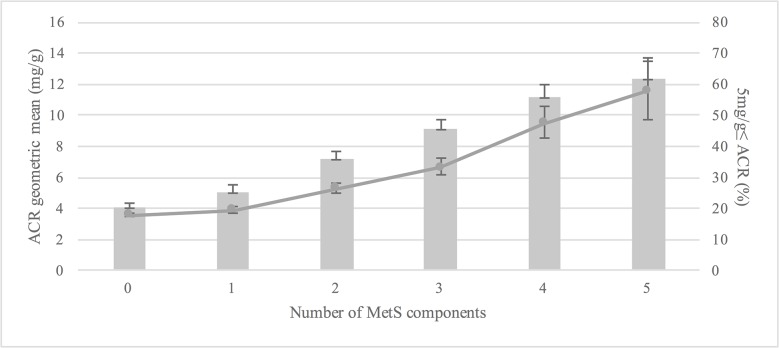
The geometric mean ACR values and the percentage of subjects with ACR values over 5 mg/g with an increase in the number of MetS components.All p for trends are <0.001. The geometric mean values of ACR were presented as a line, and the percentage of subjects with ACR values over 5 mg/g was presented as a bar graph. ACR, albumin-to-creatinine ratio; MetS, metabolic syndrome.